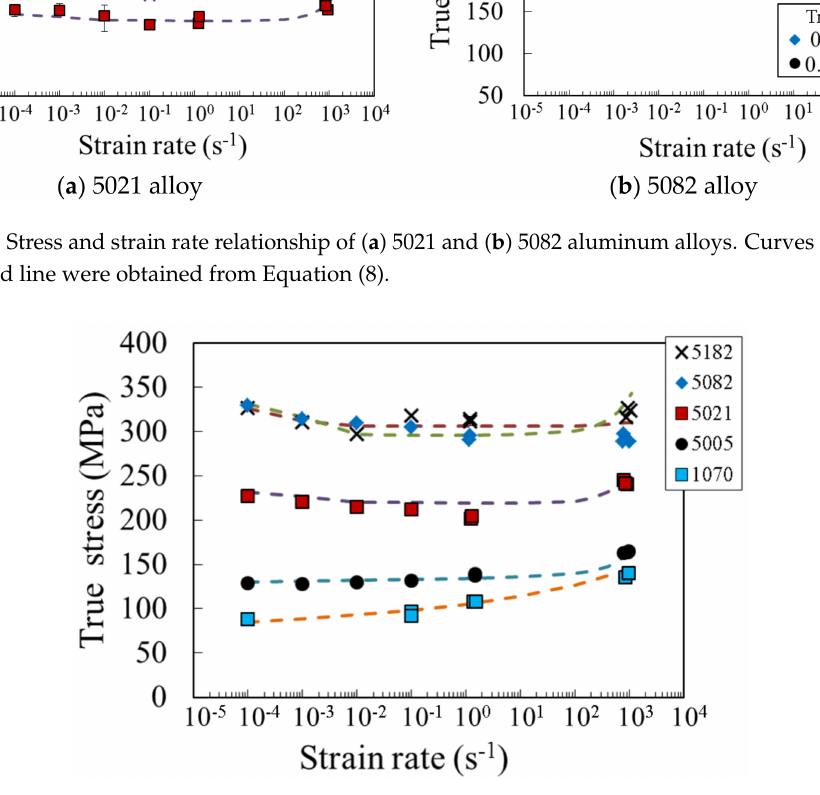
Figure 8. Relationship between flow stress and strain rate at true strain of 0.2 in investigated pure aluminum and aluminum